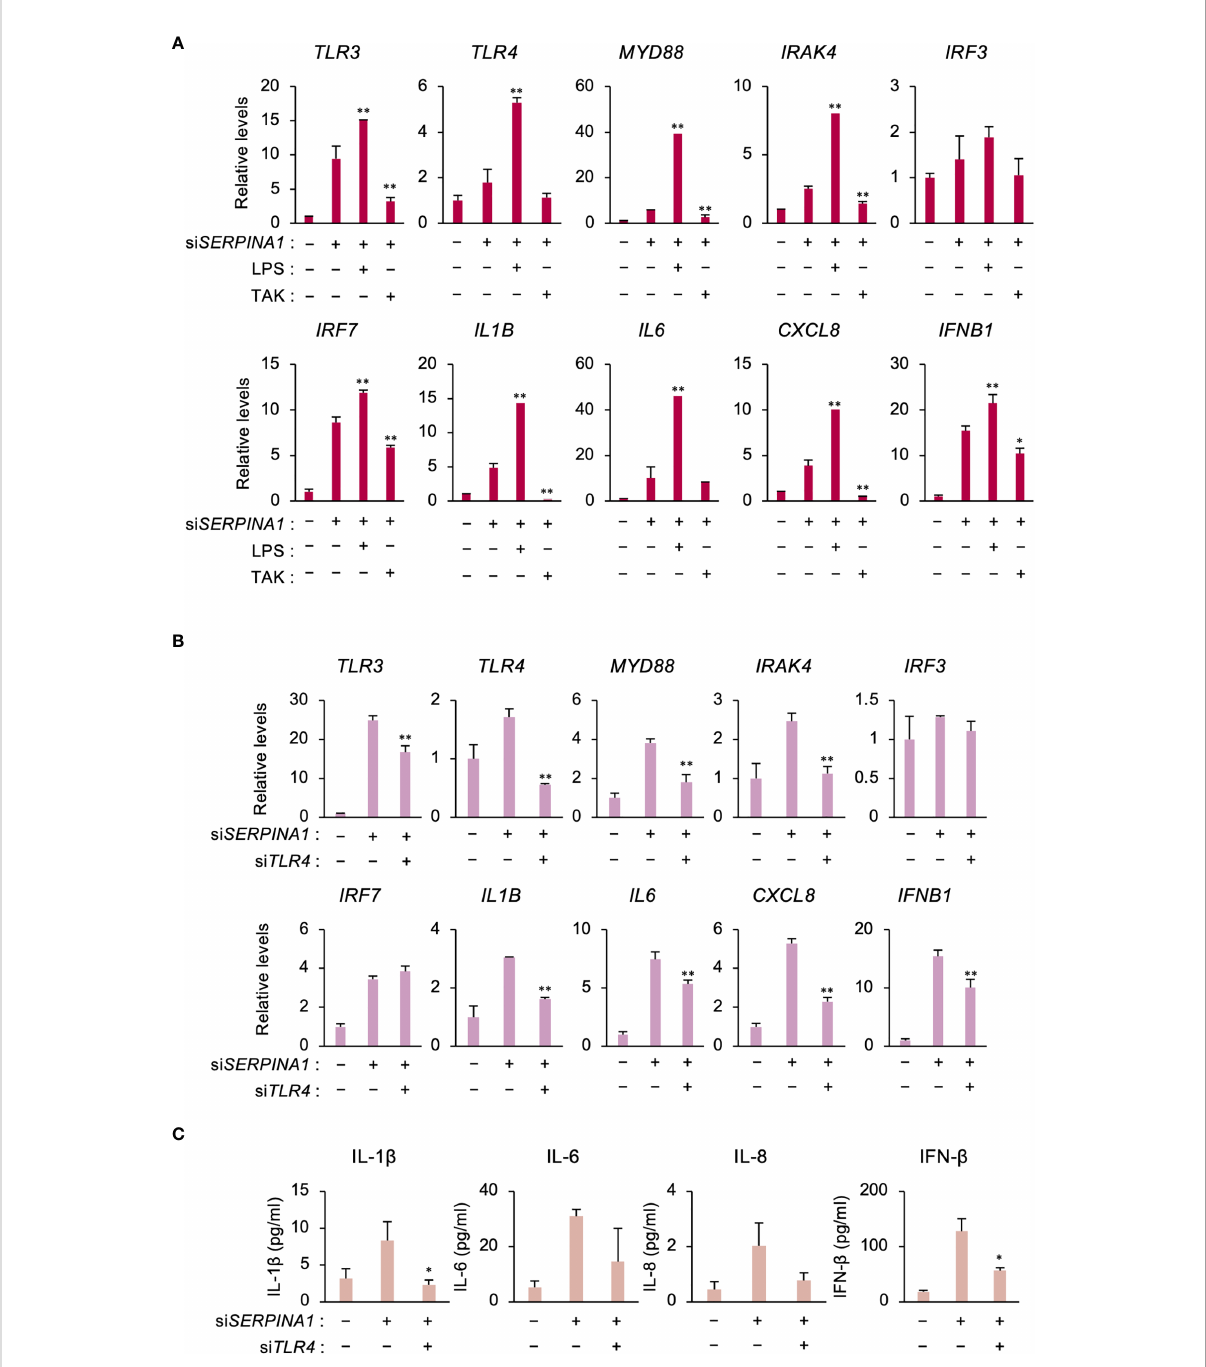
FIGURE 3 TLR4 increases expression of in fl ammatory-related genes in SERPINA1-silenced ESCs. (A) Expression of TLR3 , TLR4, MYD88, IRAK4, IRF3, IRF7, IL1B, IL6 , CXCL8, and IFNB1 in primary ESCs pre-treated with LPS (0.2 m g/ml) or TAK (10 m M) and then transfected for 24 h with si SERPINA1 (n=3). GAPDH was used as the reference gene. Values represent the mean ± SEM of three independent experiments. * P <0.05, ** P <0.01 vs. si SERPINA1 alone. (B, C) Primary ESCs transfected for 24 h with si SERPINA1 and/or si TLR4 . (B) Expression of TLR3 , TLR4, MYD88, IRAK4, IRF3, IRF7, IL1B, IL6 , CXCL8, and IFNB1 by ESCs (n=3). GAPDH was used as the reference gene. Values represent the mean ± SEM of three independent experiments. * P <0.05, ** P <0.01 vs. si SERPINA1 alone. (C) Culture media were subjected to the ELISA to measure the concentration of IL-1 b , IL-6, IL-8, or IFN- b secreted from primary ESCs. Values represent the mean ± SEM of three independent experiments. * P <0.05 vs. si SERPINA1